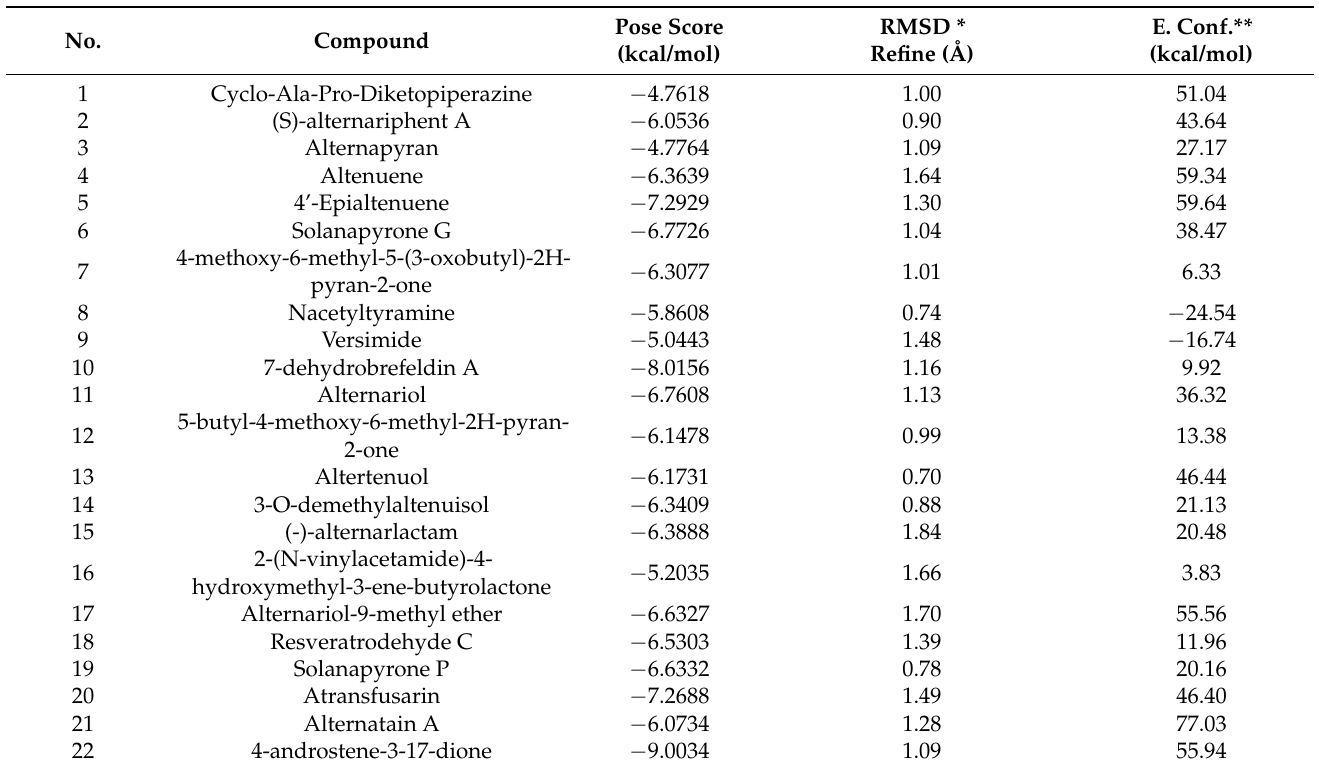
Table 5. Docking score of identified compounds against human placental aromatase cytochrome P450 (CYP19A1) (PDB ID: 3S79).